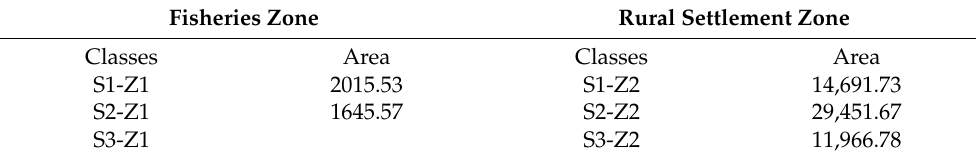
Table 4. Classification and land allocation for fishponds in fishing zones and rural